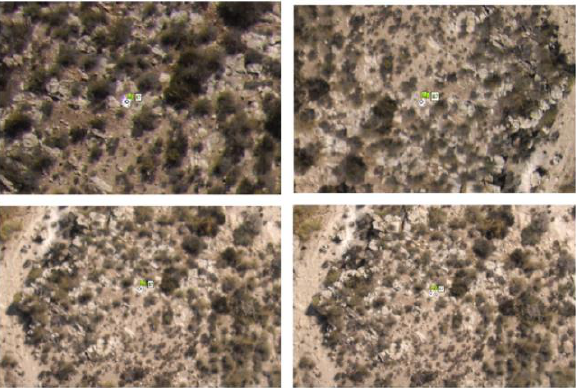
Figure 6. Identification of a control point in all the images where it appears The accuracy of the georeferencing process depend on redundancy of identified control points and precision of identification. The number of images where each of the 33 control points were identified oscillated between 3 and 14, been more than a half of control points in 11 images or